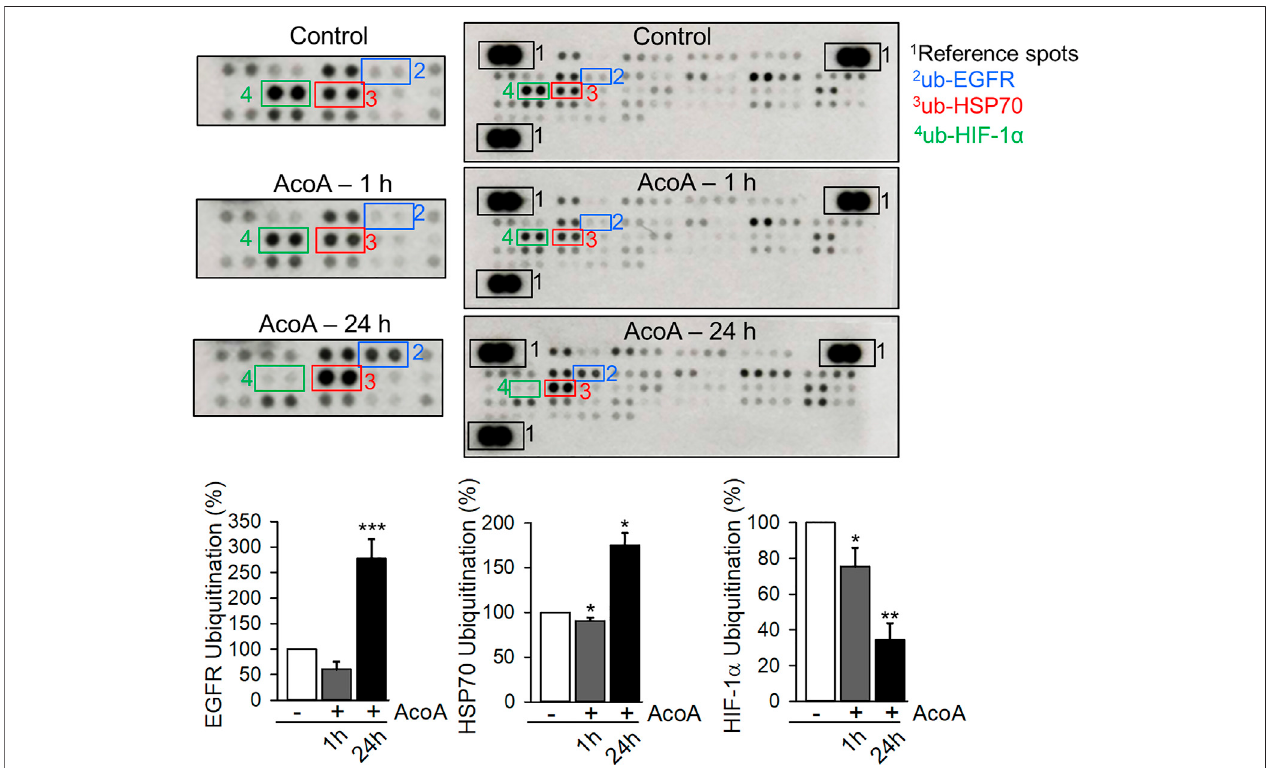
FIGURE 7 | AcoA enhances EGFR ubiquitination (A) AcoA affects the ubiquitination of EGFR, HIF-1 α and HSP70 in A549 cells. The analysis was performed by protein array. Pixel density was quanti fi ed using ImageJ software and compared to the pixel density of the control. Representative membranes are shown. Data are mean ± SEM of N (cid:1) 3 independent experiments, * p < 0.05, ** p < 0.01, *** p < 0.001 vs. vehicle-treated